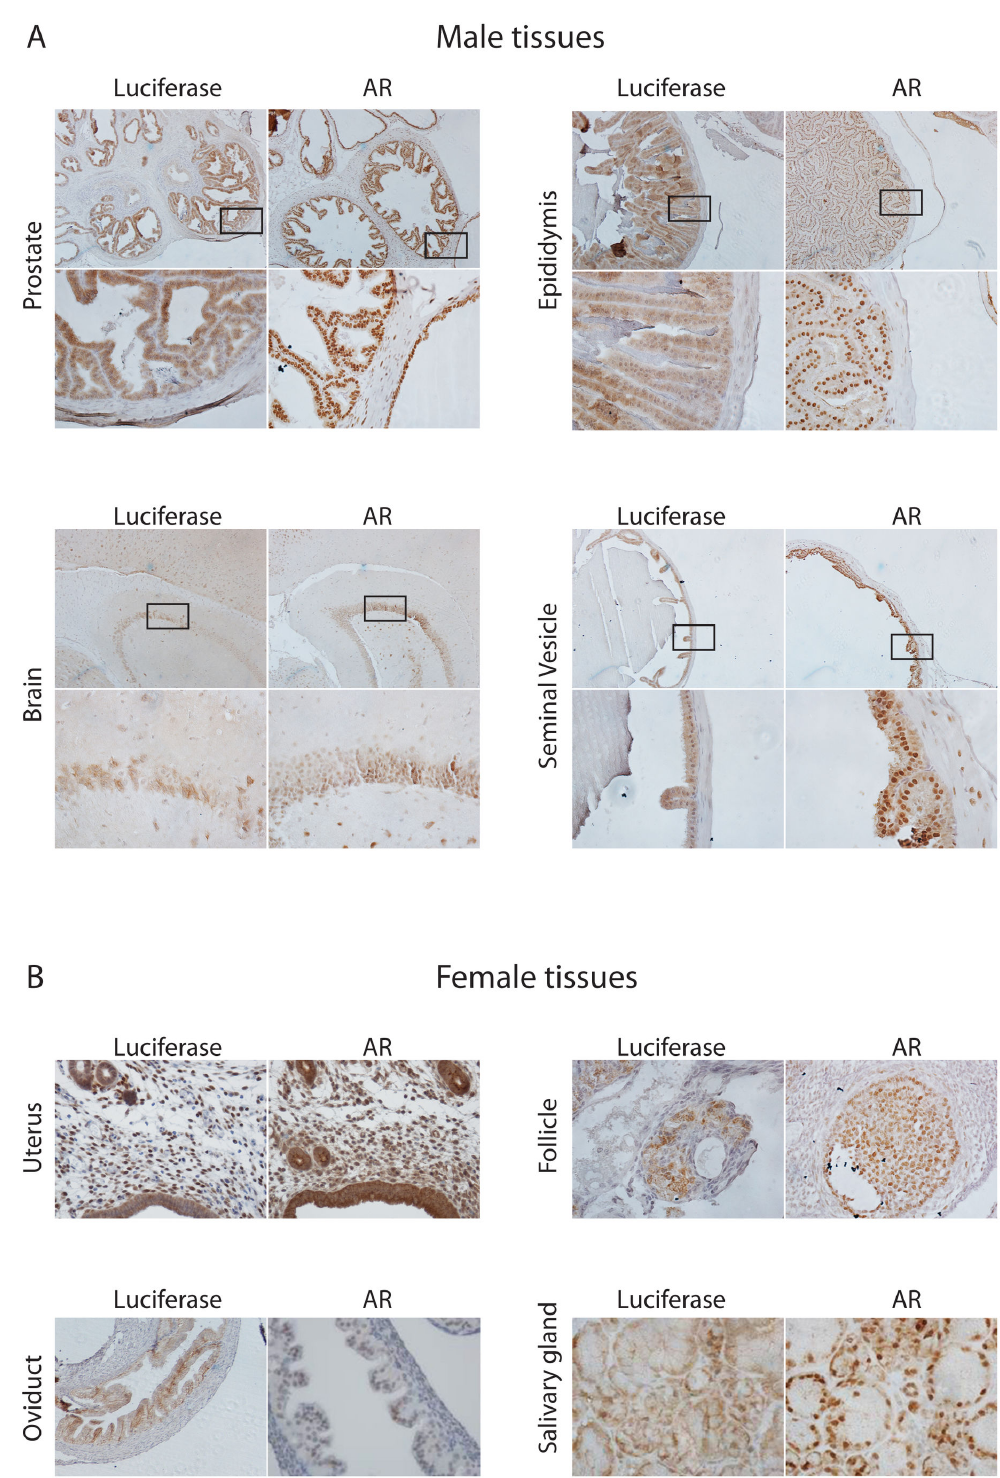
Figure 6. Analysis of AR and luciferase expression within a sample of mouse tissues. ( A ), Immunohistochemical co- localisation staining for AR (nuclear and cytoplasmic_ and luciferase (cytoplasmic) on consecutive formalin-fixed tissue sections taken from the ARE-Luc male mice. Upper panel represents image at 10x magnification, with box inset and lower panel showing 40x magnification. (B), Immunohistochemical staining for AR in a variety of female mouse tissues. doi: 10.1371/journal.pone.0071694.g006 PLOS ONE |